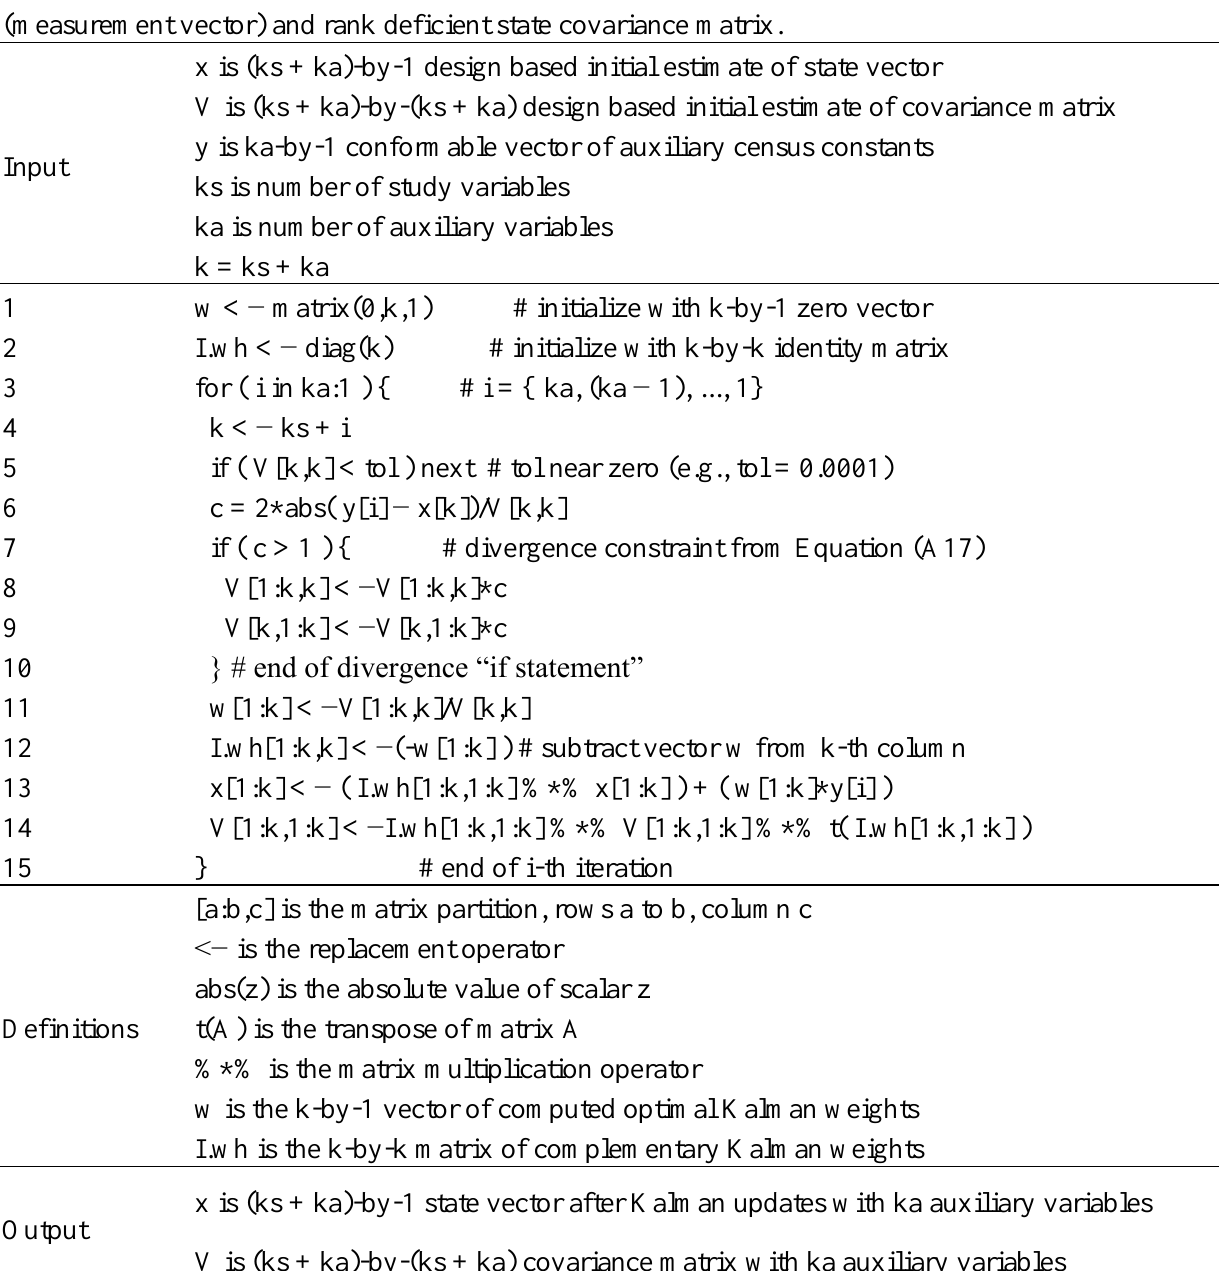
Algorithm 1 R code that applies sequential Kalman filter (KF) update with known observation constants (measurement vector) and rank deficient state covariance